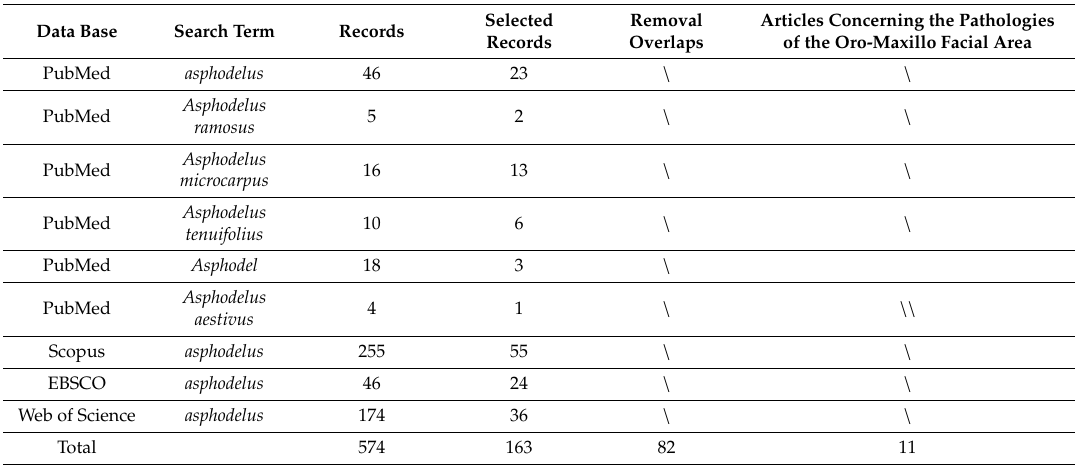
Table 1. Complete overview of the search methodology. Records identified by databases: 574; articles selected for qualitative analysis: